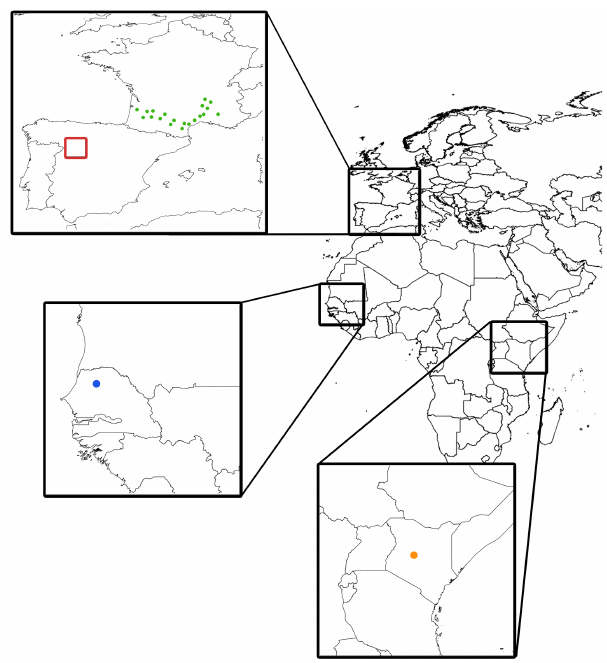
Figure 2. Location of the networks used for validation in this study (SMOSMANIA, France, green dots; REMEDHUS, Spain, red rect- angle; Dahra, Senegal, blue dot; Cosmos, Kenya, orange